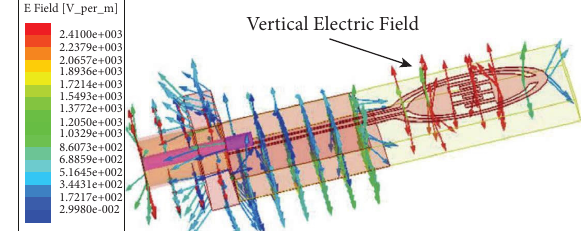
Figure 4: Electric feld distribution to confrm the ZOR mode at 2.72GHz.